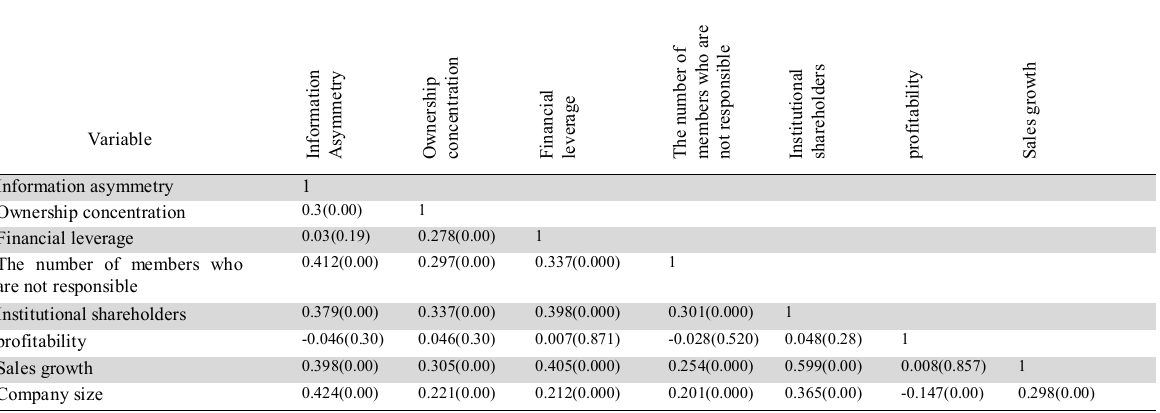
Pearson correlation coefficient